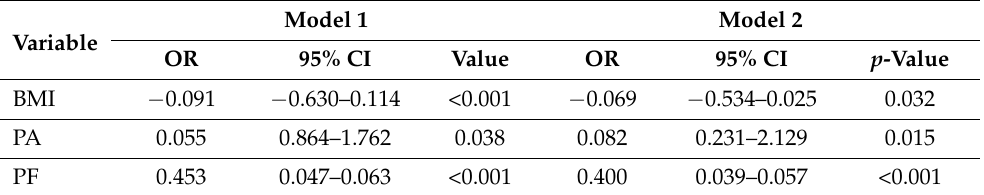
Table 3. Results of linear regression analysis models for BMI and